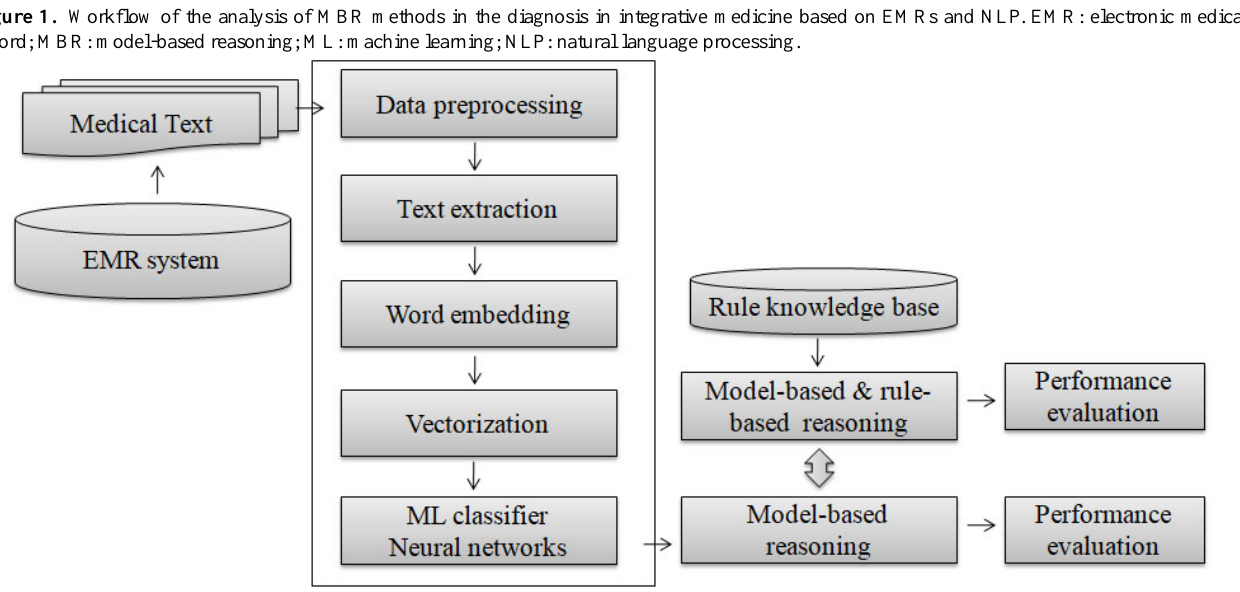
Figure 1. Workflow of the analysis of MBR methods in the diagnosis in integrative medicine based on EMRs and NLP. EMR: electronic